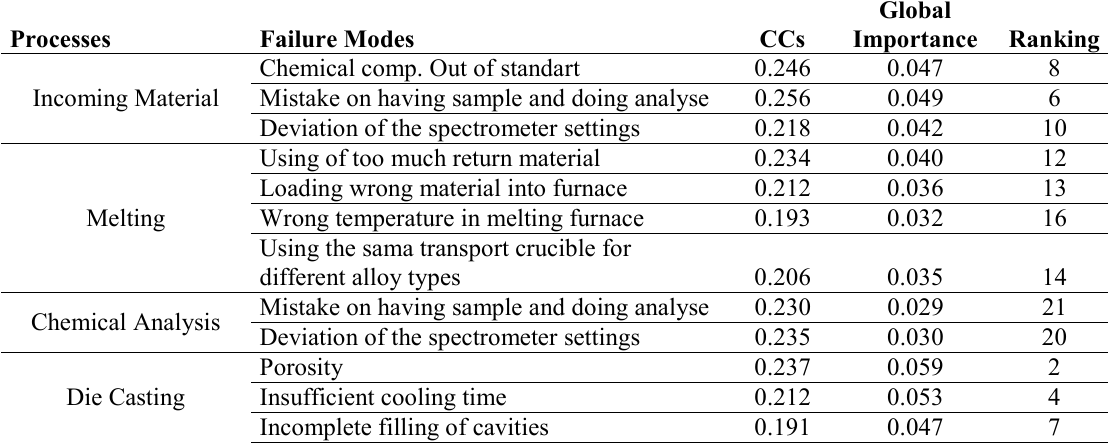
Table 8. The importance of each potential failure